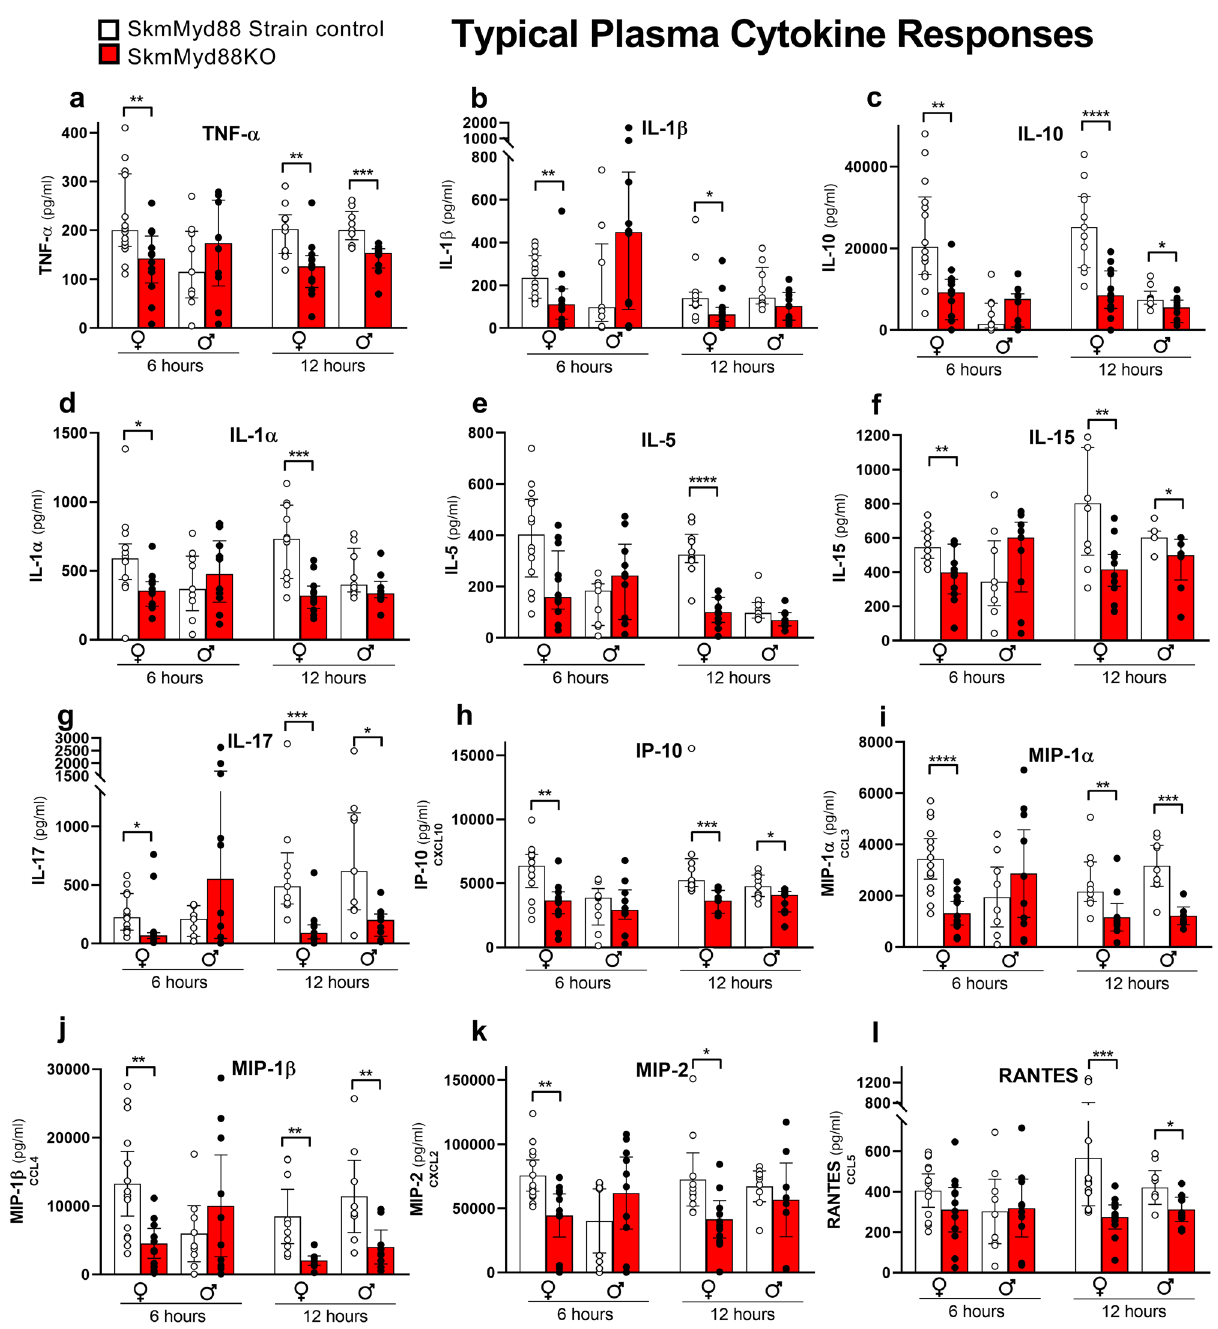
Figure 2. Typical plasma cytokine responses of some cytokines important in sepsis in skmMyd88KO (red) vs. skmMyd88 strain controls (white). Unpaired comparisons were within strains and sexes *P < 0.05, **P < 0.01. n = 9–12 in each group. Data expressed as medians ± 25–75% quartiles. All data met a false discovery rate of <